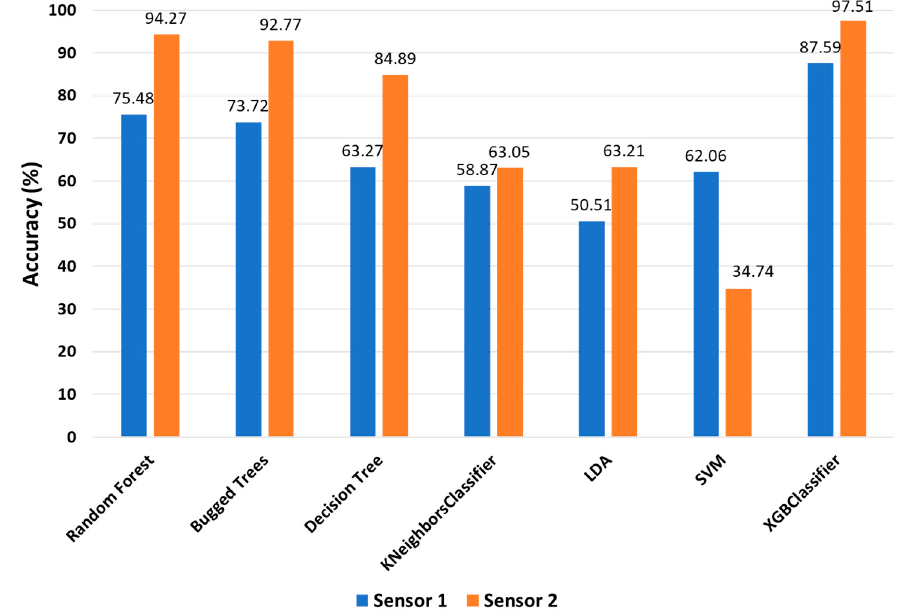
Figure 5. Accuracy of classifiers for both sensors with 513 features.